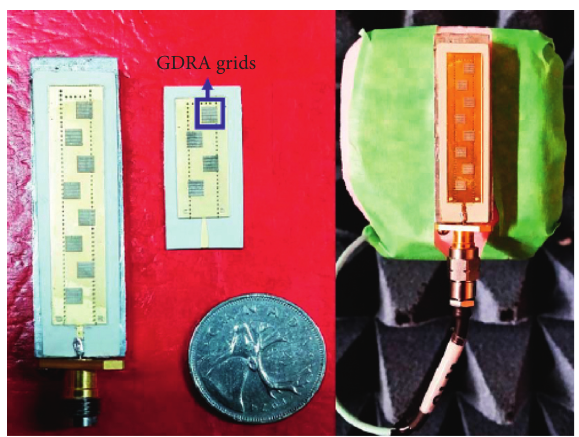
Figure 12: Illustration of the 1 × 8 (on the left) and 1 × 4 (on the right) GDRA arrays realized in [83] ©2019 IEEE.